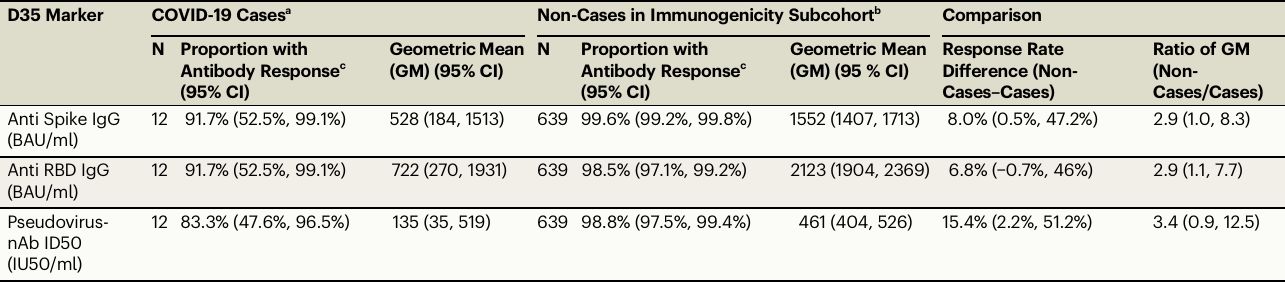
a Cases are baseline SARS-CoV-2 seronegative per-protocol vaccinerecipientswiththeprimaryCOVID-19 endpoint(symptomatic RT-PCR-con fi rmedCOVID-19)starting 7 dayspost D35 visit throughtothe data cut(April 19, 2021). b Non-casesarebaselinenegativeper-protocolvaccinerecipientssampledintotheimmunogenicitysubcohortwithnoevidenceofSARS-CoV-2infection(i.e.,nevertestedRT-PCRpositive)upto theend of the correlates studyperiod (thedatacut-off dateApril 19, 2021). c Antibodyresponse de fi nedbyIgGconcentration above theassay positivitycut-off (10.8424 BAU/ml)orbydetectable ID50>limitofdetection(LOD)=2.612IU50/ml. Analysis basedonbaseline SARS-CoV-2 negative per-protocol vaccinerecipients inthe case-cohort set.Median (interquartilerange) daysfrom vaccinationtoD35was